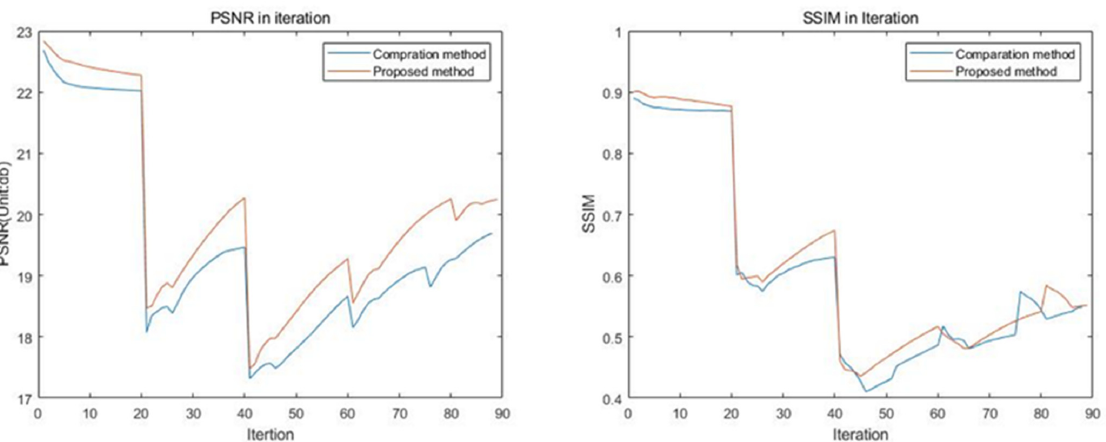
Figure 3. Levin image restoration experiment. Left is PSNR and right is SSIM. This paper used the same parameters and solution methods to test the performance of the two regular terms of WG-NGM and NGM under the same conditions.